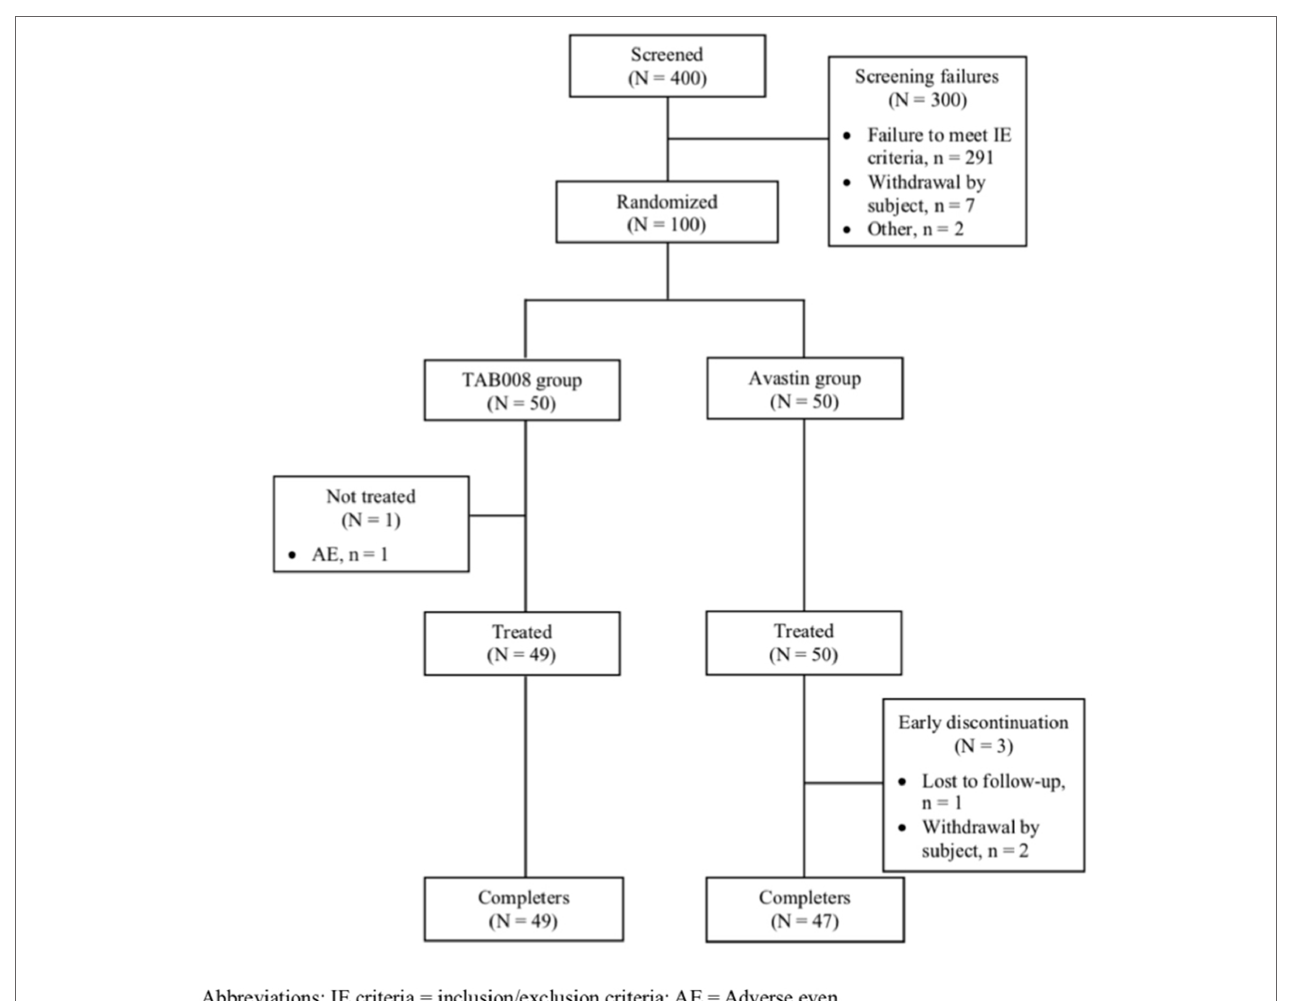
FIGURE 1 | Subjects dispositions for TAB008 group versus Avastin ®